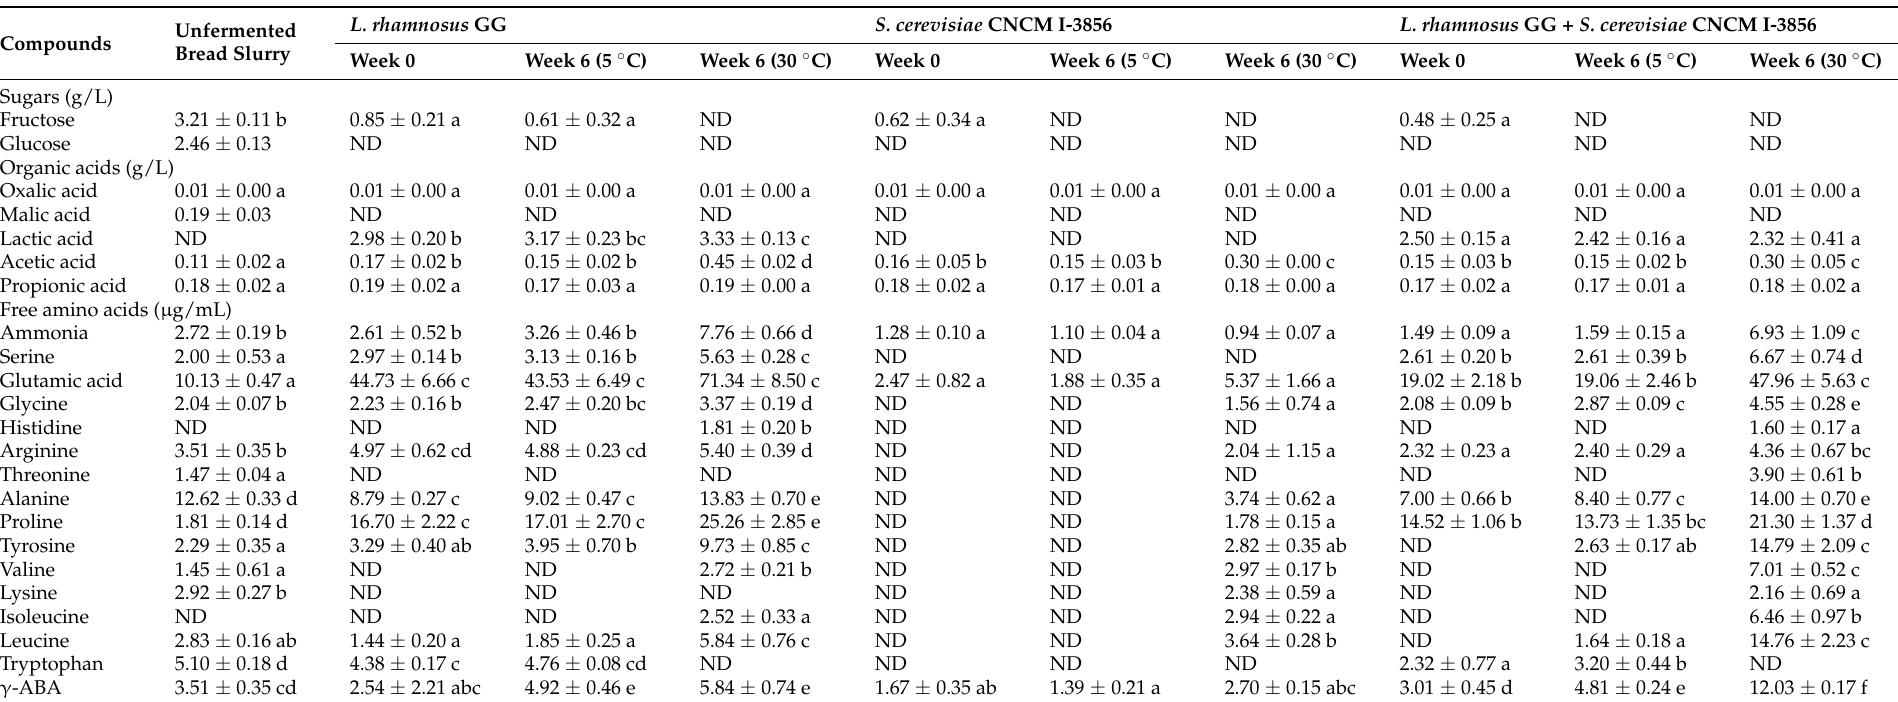
Table 1. Contents of identified sugars, organic acids, and free amino acids in unfermented and fermented bread slurries at the beginning and end of shelf life monitoring.